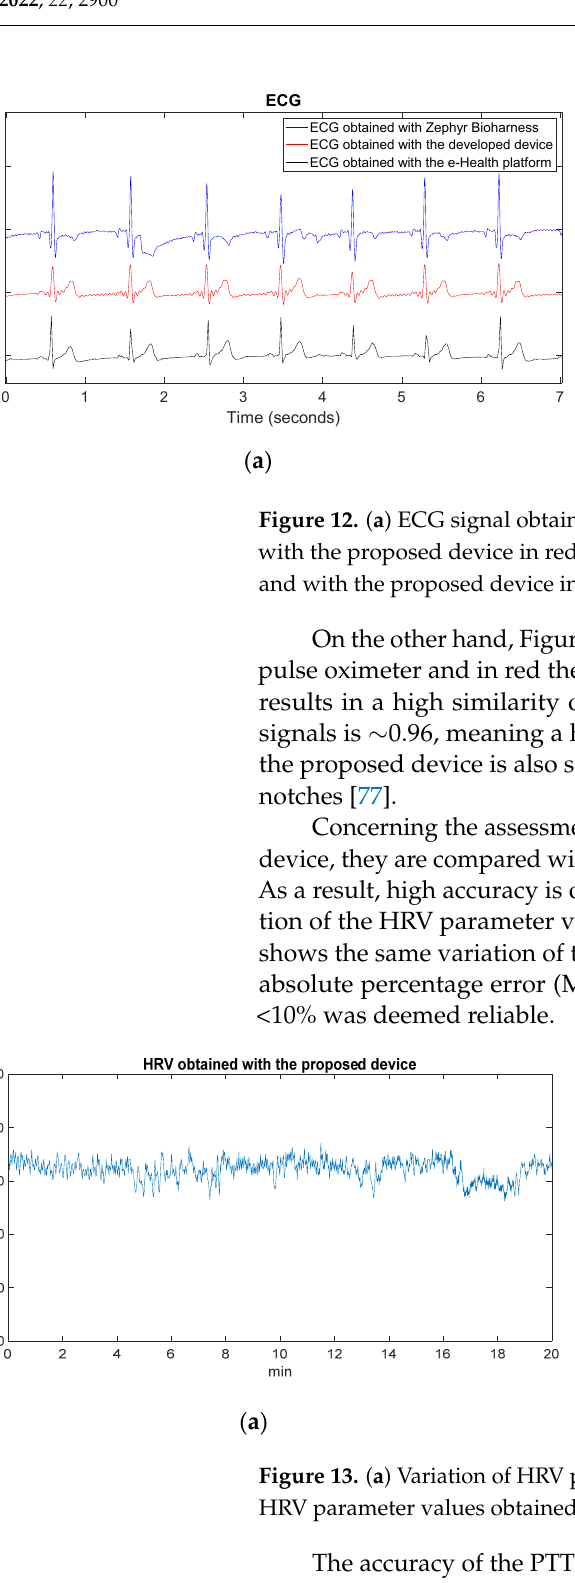
Figure 13. ( a ) Variation of HRV parameter values obtained with the proposed device; ( b ) Variation of HRV parameter values obtained with Zephyr Bioharness.